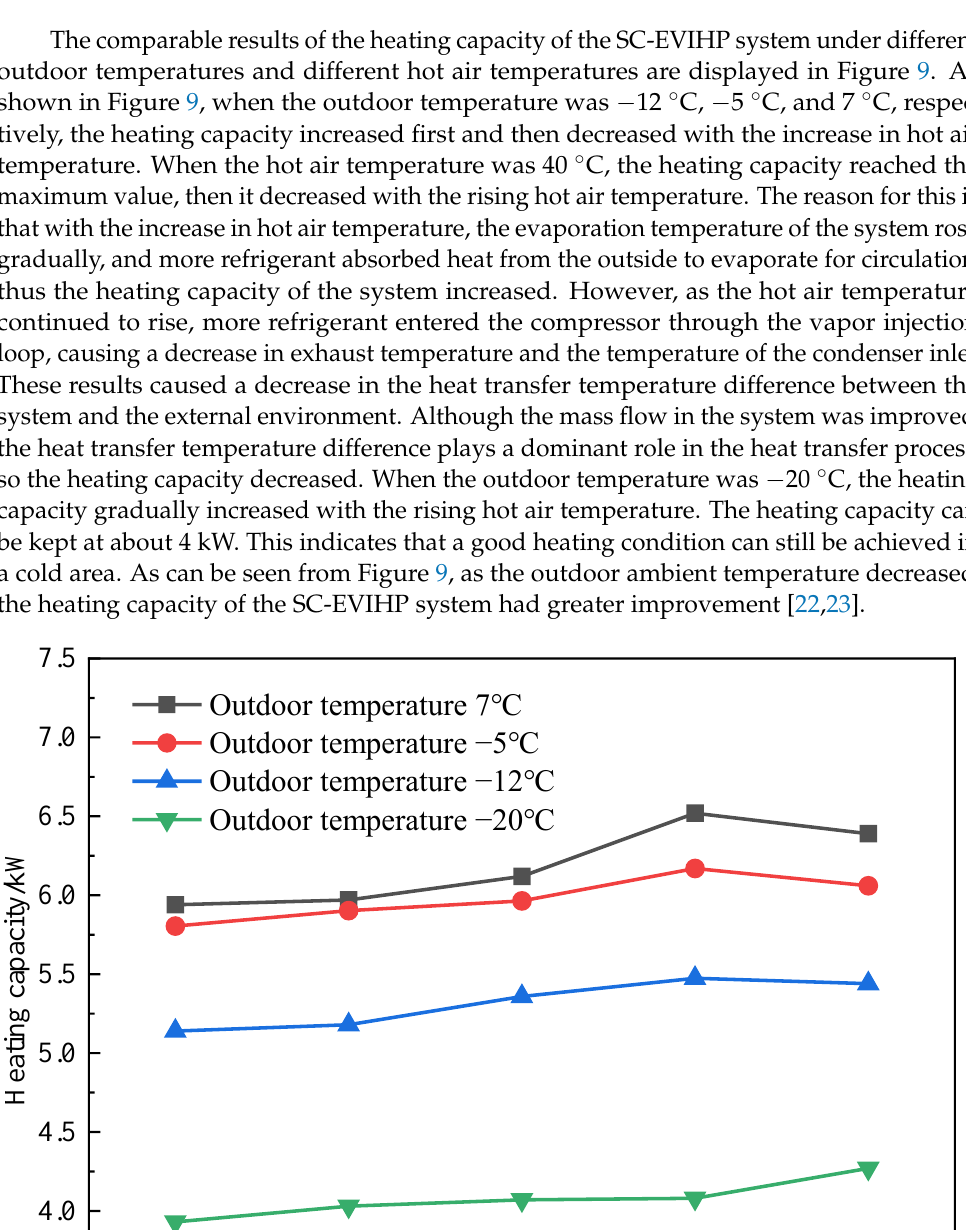
Table 3. Operational performance of the EVI-ASHP system at different outdoor temperatures. Outdoor Indoor Heating Power Temperature/ ◦ C Temperature/ ◦ C Capacity/kW Consumption/kW − 20